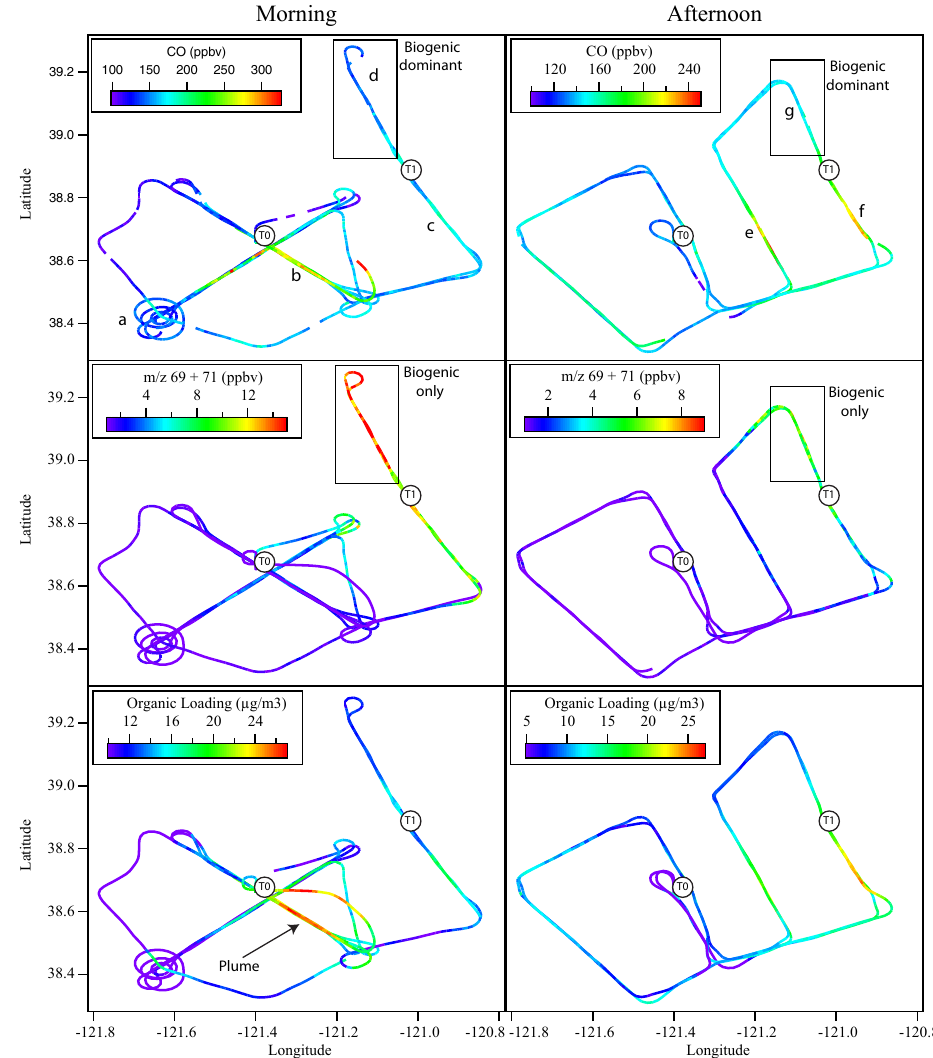
Fig. 3. 28 June G-1 morning and afternoon flight tracks colored by CO, the sum of m / z 69 (mainly isoprene) and 71 (MVK+MACR), and OA concentrations. The arrow indicates the mixed anthropogenic/biogenic plume. The boxed indicates the area influenced primarily by biogenic emissions. T0 and T1 symbols indicate locations of the ground sites. Letters are used to identify important portions of the flight track and correspond to the letters in shown in Fig.